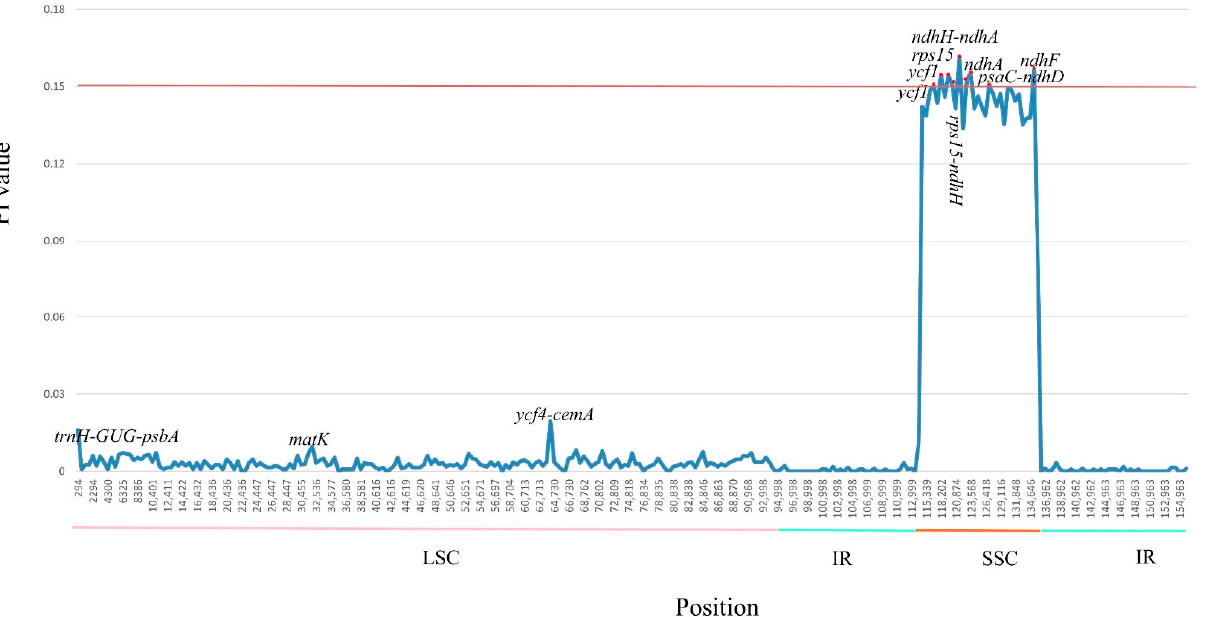
Figure 6. Comparison of the nucleotide variability (Pi) values among the whole chloroplast genome of five Machilus species. X-axis: positions of the midpoints of a window, Y-axis: nucleotide diversity in each window.